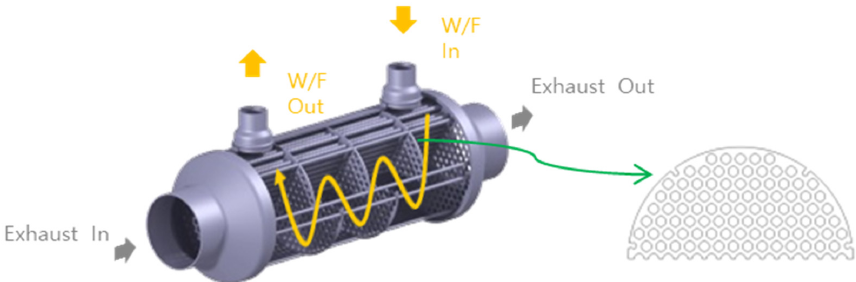
Figure 3. Shell- and tube-type heat exchangers used for the HT and LT evaporators.